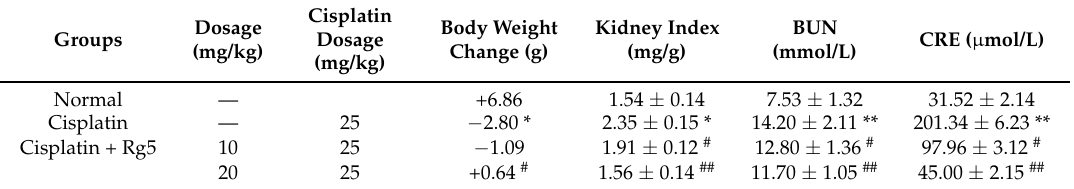
Table 1. Effects of ginsenoside Rg5 on body weight change, kidney index and serum markers in cisplatin-induced acute kidney